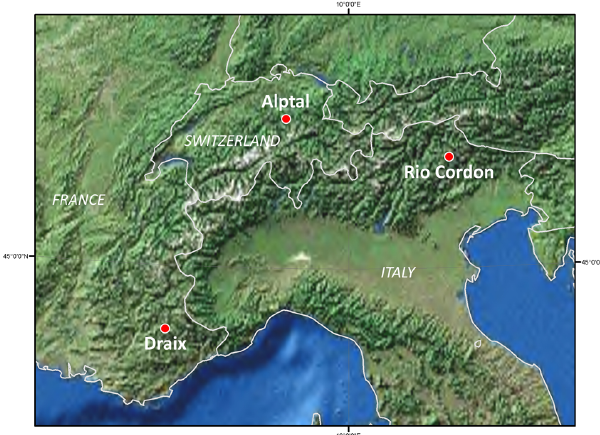
Fig. 1. Location of the three experimental sites: Alptal (Swiss Prealps), Rio Cordon (Eastern Italian Alps) and Draix (Southern French